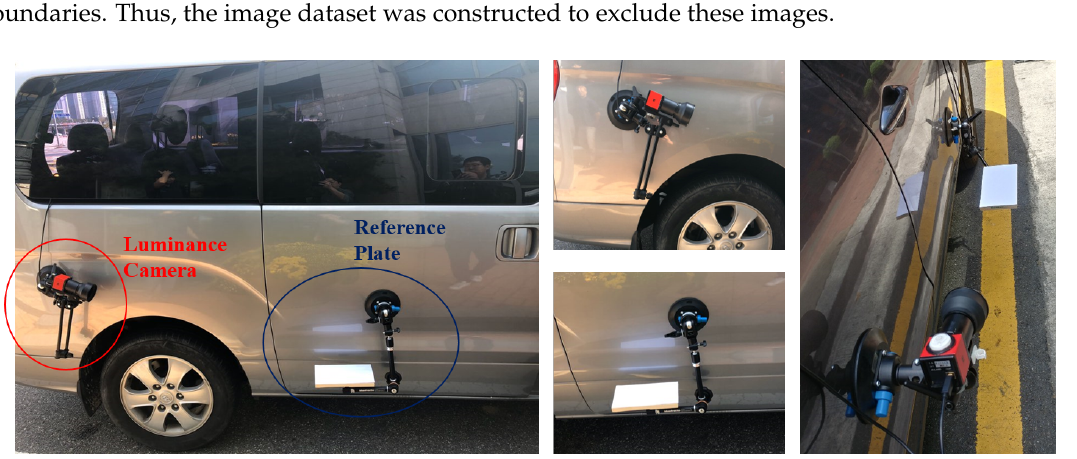
Figure 3. Placement of the luminance camera and reference plate on a vehicle used to capture luminance images. Table 1. Numbers of luminance images for training and